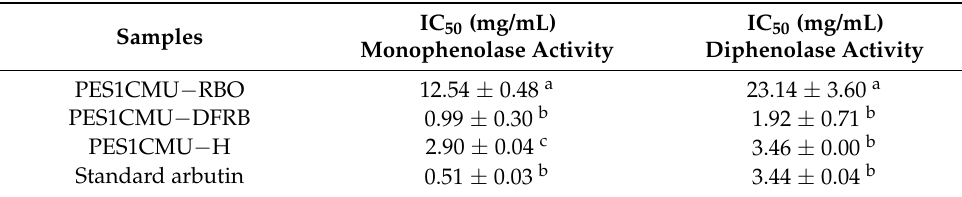
Table 1. Inhibitory effects of Oryza sativa L. cv. PES1CMU extracts on cell-free mushroom tyrosinase activity.